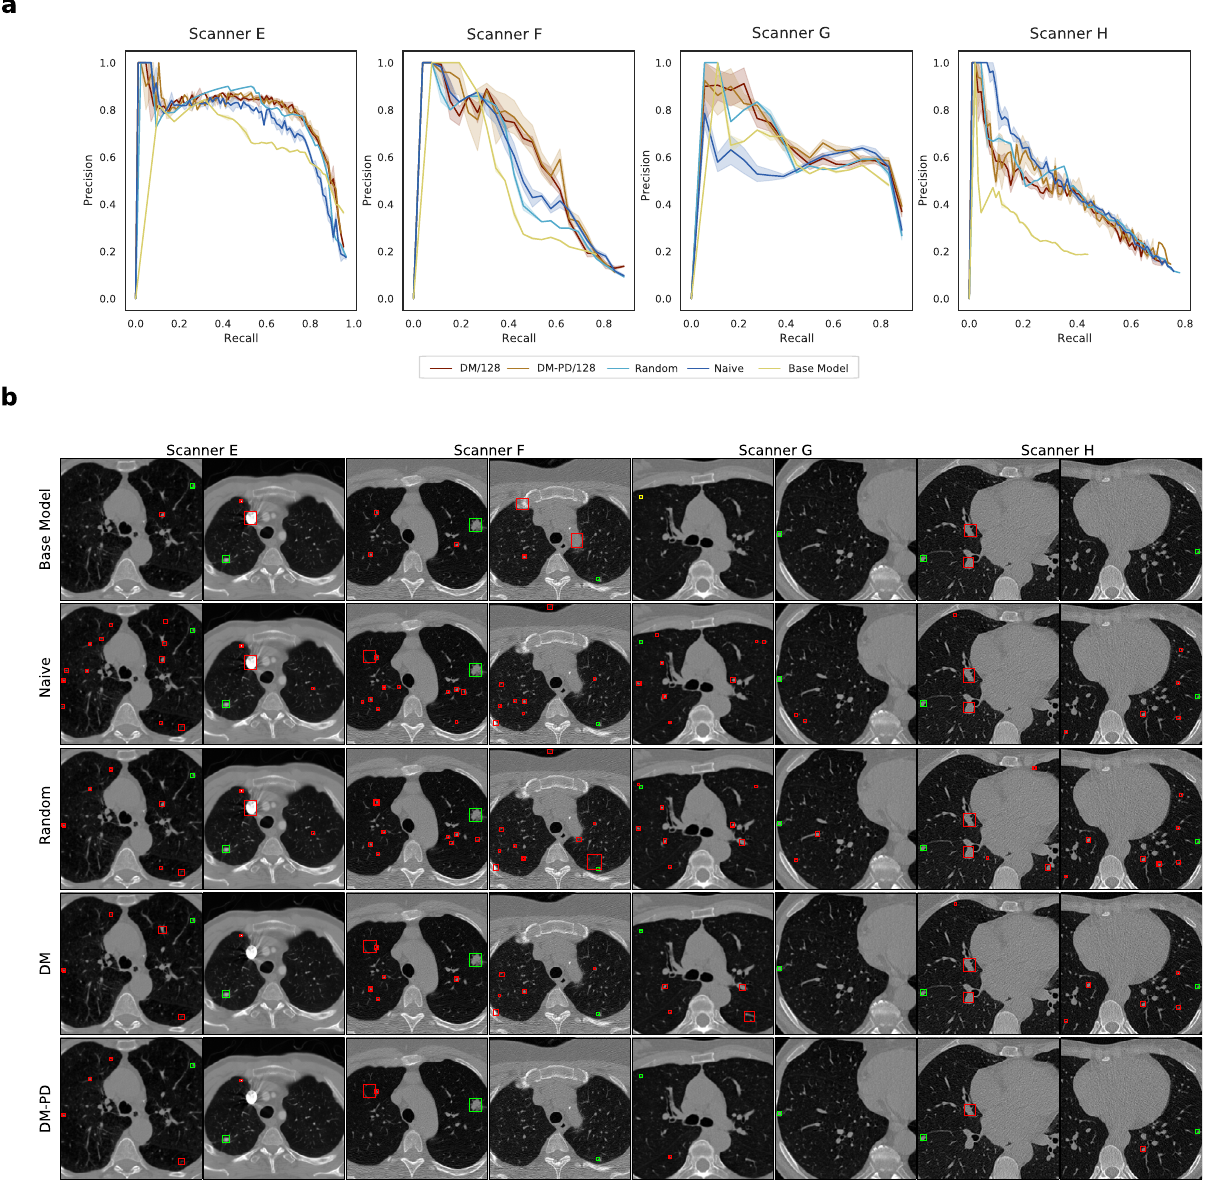
Fig. 5 Quantitative and qualitative results for lung nodule detection. a Precision – recall curves of the fi nal naive, DM and DM-PD trained model compared to a base model trained on only scanner E data. Shaded areas represent con fi dence intervals for n = 5 independent training runs. b Samples of lung nodule detection of the fi nal naive, DM and DM-PD trained model compared to a base model trained on only scanner E data on all four domains. Green boxes indicate true-positives, yellow boxes false-negatives and red boxes